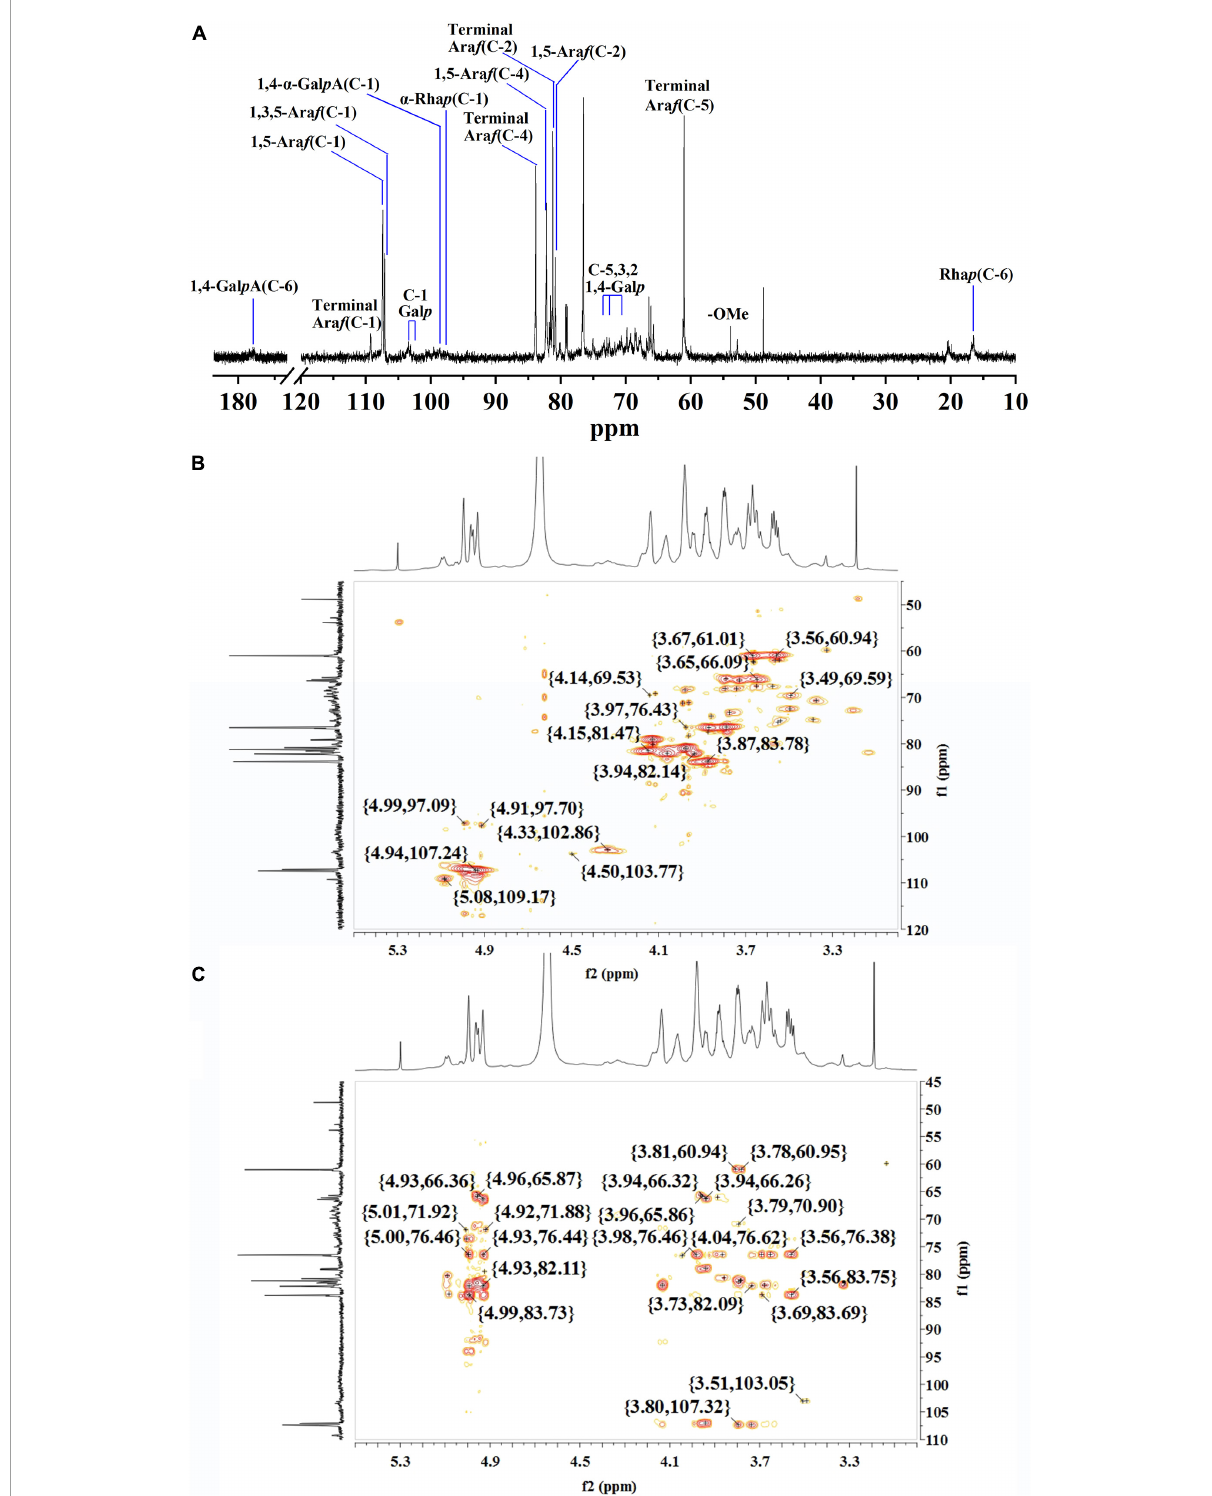
FIGURE4 Nuclear magnetic resonance (NMR) spectra of WLJP-A0.2b-E1. (A) 13 C NMR spectrum. (B) HSQC spectrum. (C) HMBC